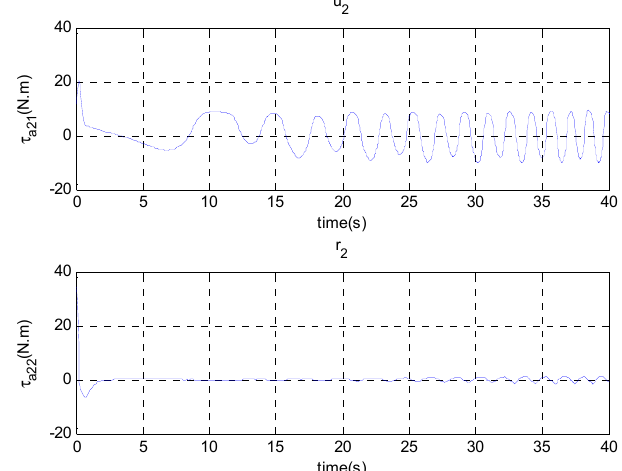
Figure 13. Applied input control of the second follower in Example 2.